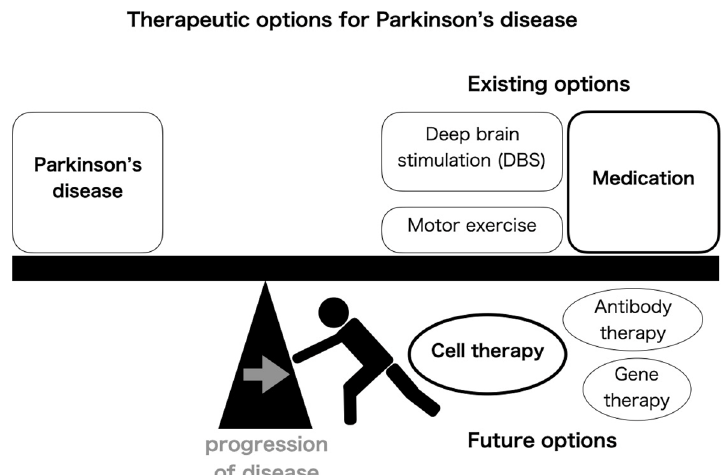
Fig. 2 Therapeutic options for Parkinson’s disease. PD is a progressive disease. Existing therapeutic options include medication, DBS, and motor exercise, but all are symptomatic therapies. Cell therapies for PD are expected to become a standard therapeutic option in the future that can stop or reverse the disease